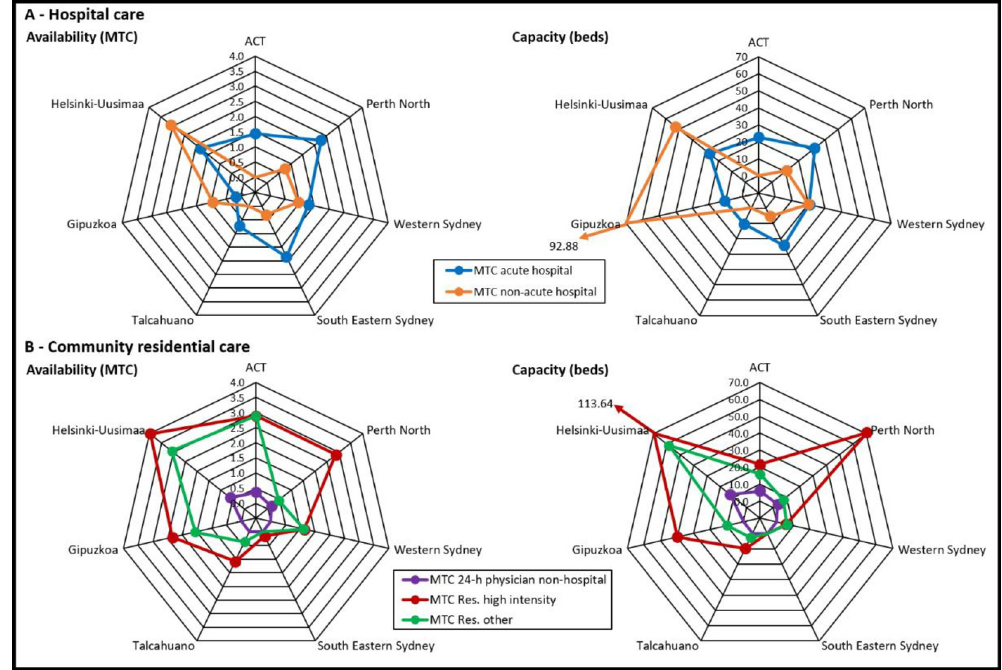
Fig 2. Availability of residential care per 100,000 adults: Australian and international comparison. The axes of these graphs represent each of the study regions. Coloured lines representing the different types of residential care join the points on each axis indicating the rate of that type of care per 100,000 adults for that